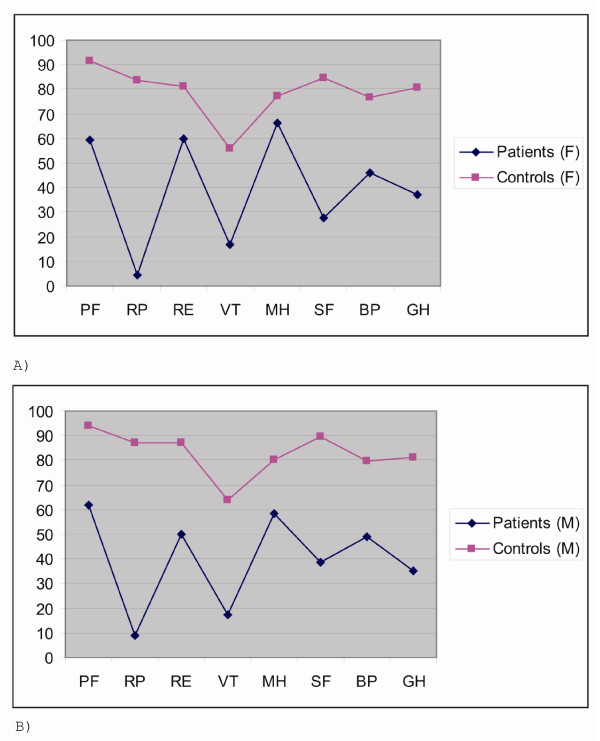
a. Mean SF-36 subscores among female patiens on follow-up and female controls. b. Mean SF-36 subscores among male patiens on follow-up and male controls. All P < .0001, Mann-Whitney U test.